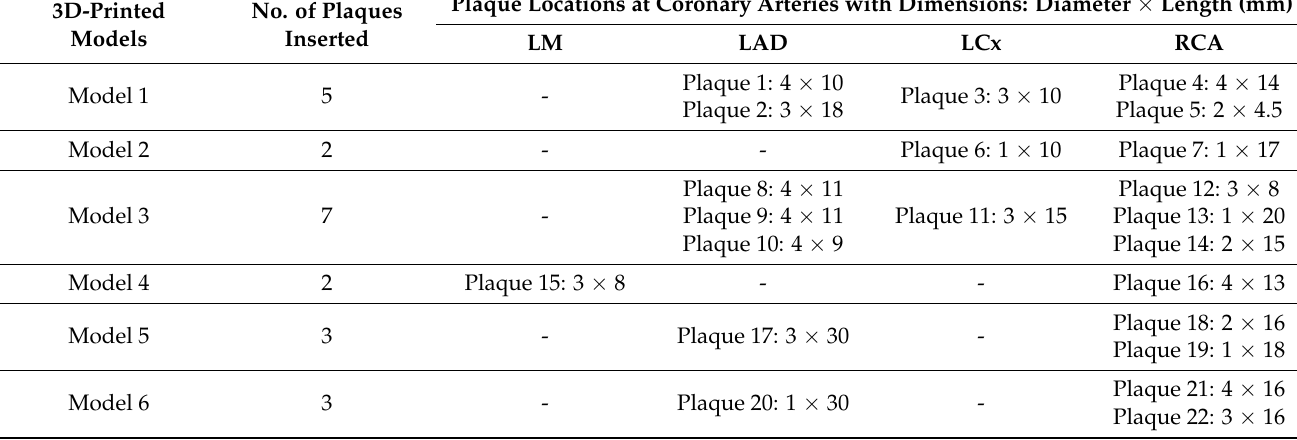
Figure 2. 3D-printed coronary artery models with simulated calcified plaques inserted into the coronary artery branches. Table 1. Dimensional details of simulated calcified plaques in 3D-printed coronary artery